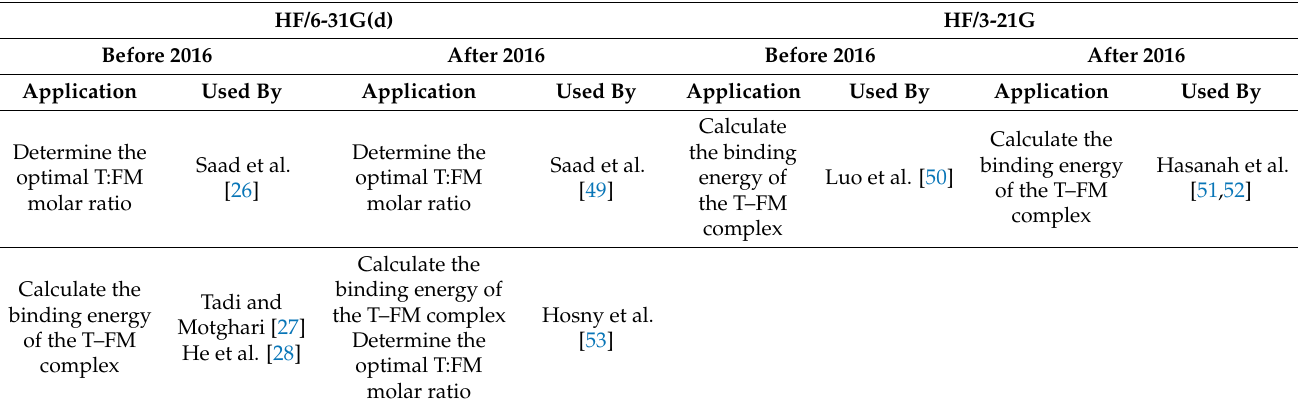
Table 1. Comparison of the ab initio approach to design molecularly imprinted polymers (MIPs) before and after